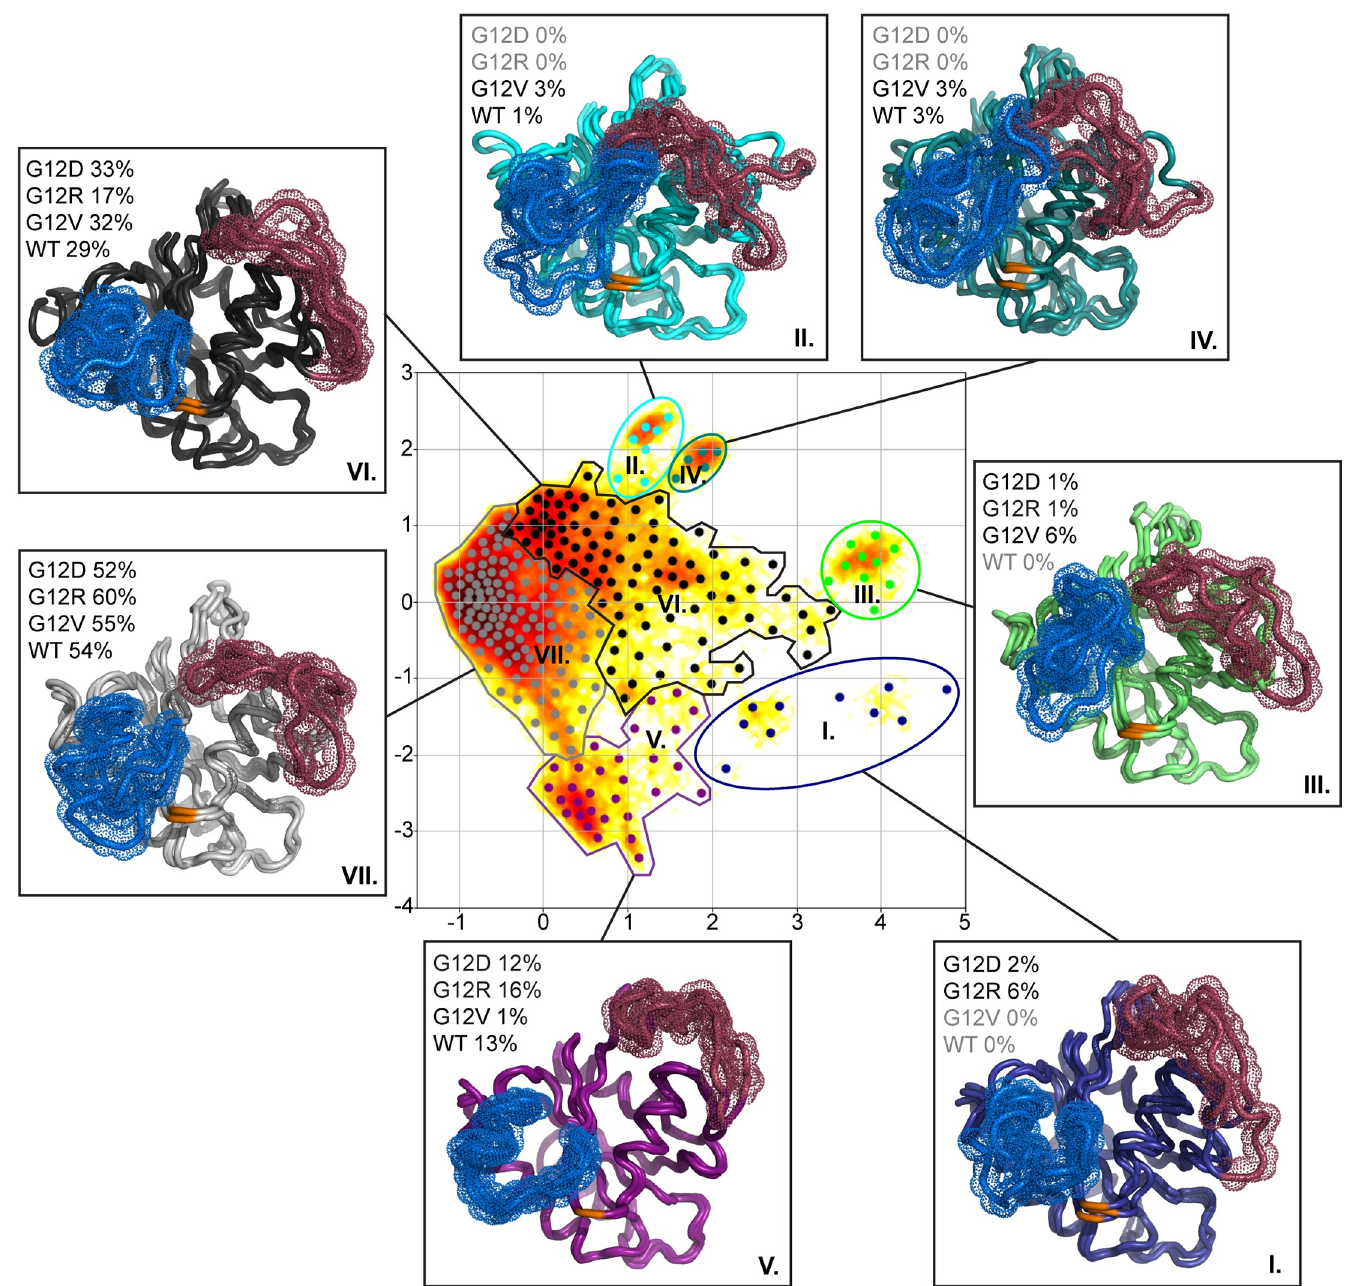
Fig 5. The seven metastable states identified by the Markov state model. In the middle is the time-lagged independent component analysis (TICA) plot showing seven clusters, each of which corresponds to one metastable state (I–VII). The metastable states are classified by borderlines, and the “microstates” (dots) in each metastable state are colored with the same color. The seven boxes around the middle describe the seven metastable states found in the MSM analysis, each box illustrating three representative protein conformations (generated using MSM), which identify the residue 12 (orange), and also the switch-I (red) and switch-II (blue) regions depicted by their backbone’s molecular surface (dots). In each metastable state, the occupation percentage by wild-type and individual mutants is displayed next to the conformations. For each case (wild-type, G12D, G12V, G12R), normalization of the percentages is done such that the sum over the seven metastable states adds up to